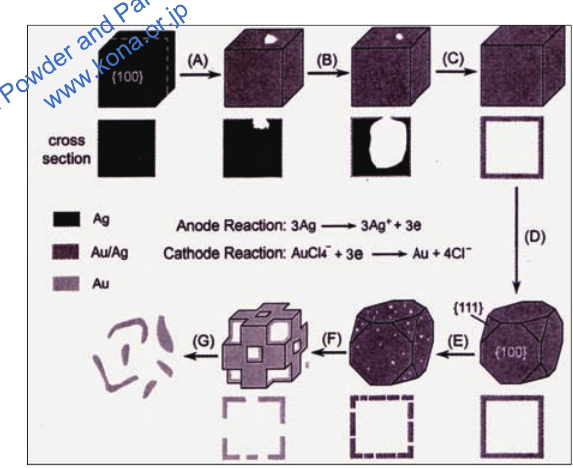
Fig. 8 Schematic illustrations on the preparation of porous Au nanoshell by templating again Ag nanoparticles 106)